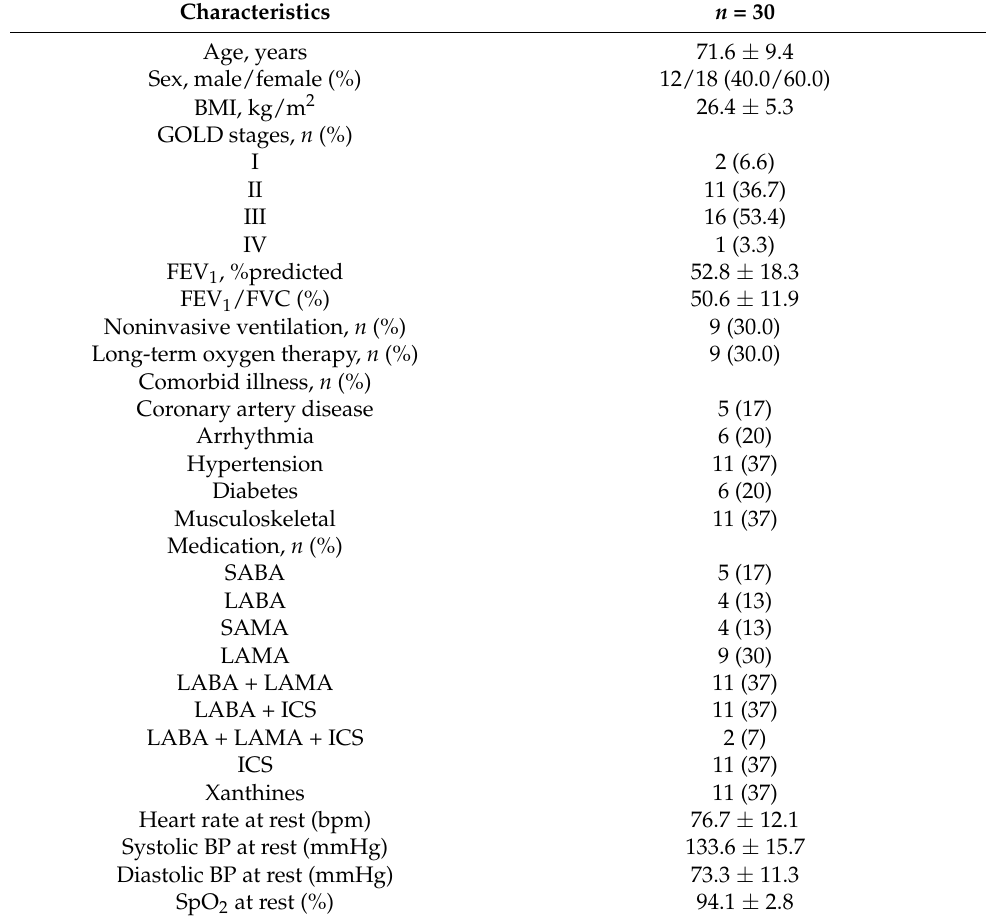
Table 1. Participant